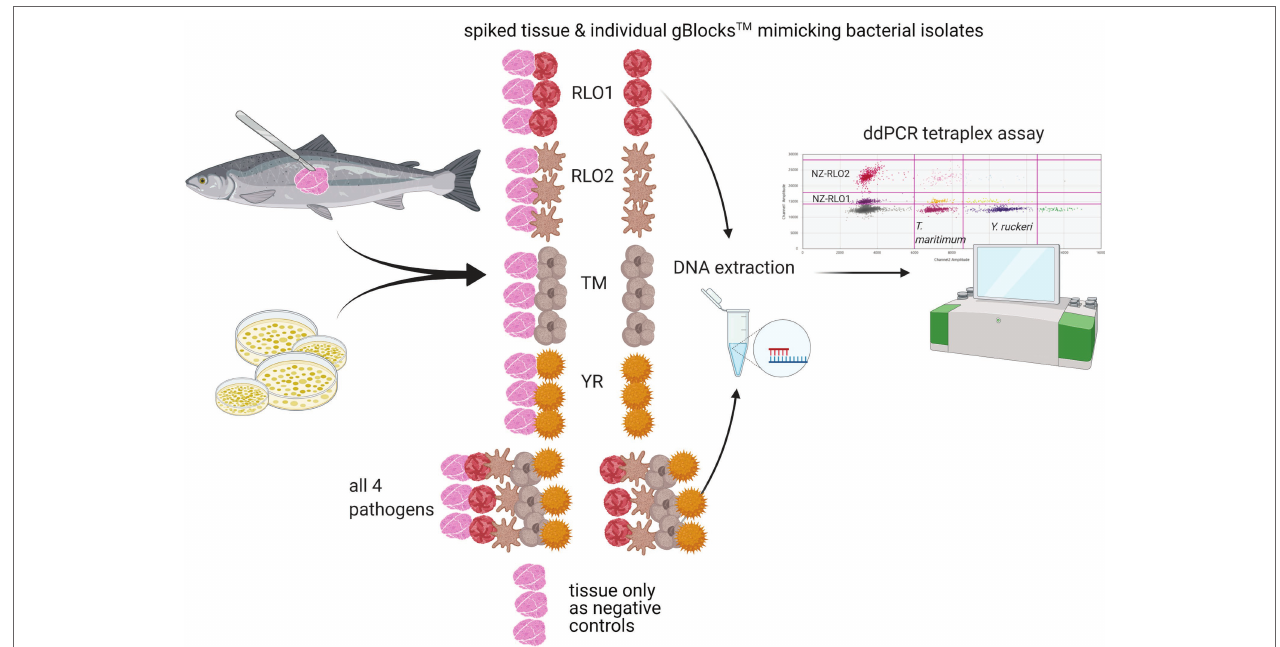
FIGURE 1 | Tetraplex assay sensitivity testing on triplicate samples of DNA from Oncorhynchus tshawytscha tissue spiked with gBlocks ™ representing either New Zealand Rickettsia -like organism 1 (NZ-RLO1), NZ-RLO2, Tenacibaculum maritimum, and Yersinia ruckeri, and triplicate samples of gBlocks ™ with no and just Oncorhynchus tshawytscha DNA were included for each pathogen individually and all together. The tetraplex assay was then run for the extracted DNA of all samples and copies/ μ l compared between samples. Schematic created with